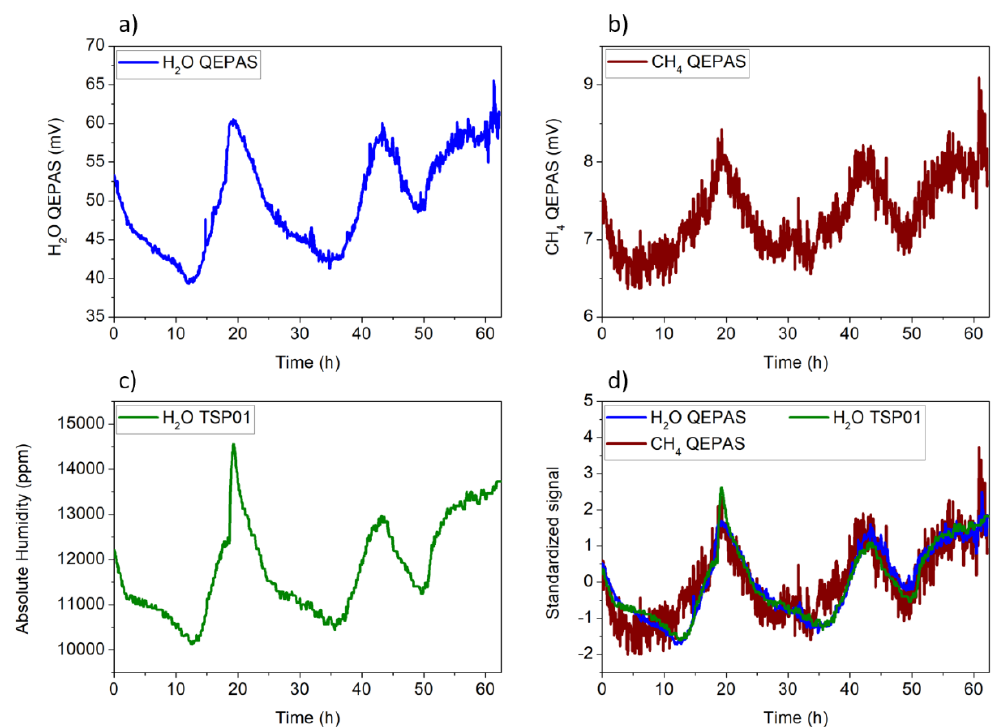
Figure 5. QEPAS peak signal vs. time for ( a ) water vapor and ( b ) methane; ( c ) absolute humidity calculated from the temperature and relative humidity detected with TSP01 and using Equation (1); ( d ) CH 4 QEPAS, H 2 O QEPAS, and absolute humidity signals standardized with respect to their mean and standard deviation values.